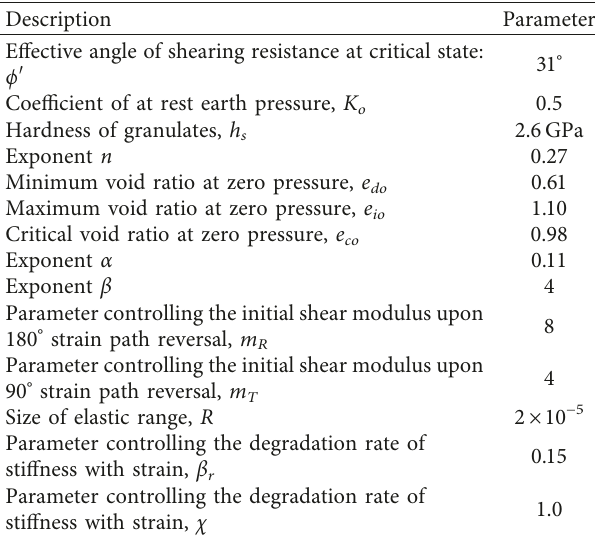
Table 2: Soil parameters used in finite element